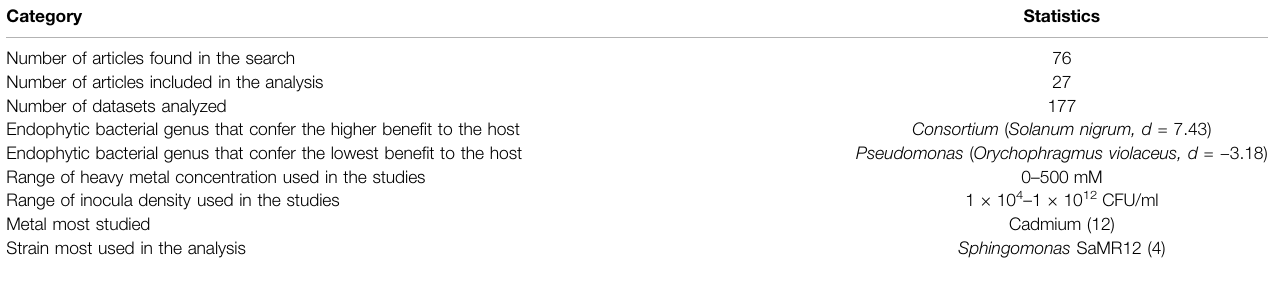
TABLE 1 | General statistics of articles found in the databases about the effect of endophytic bacteria on plant heavy metal